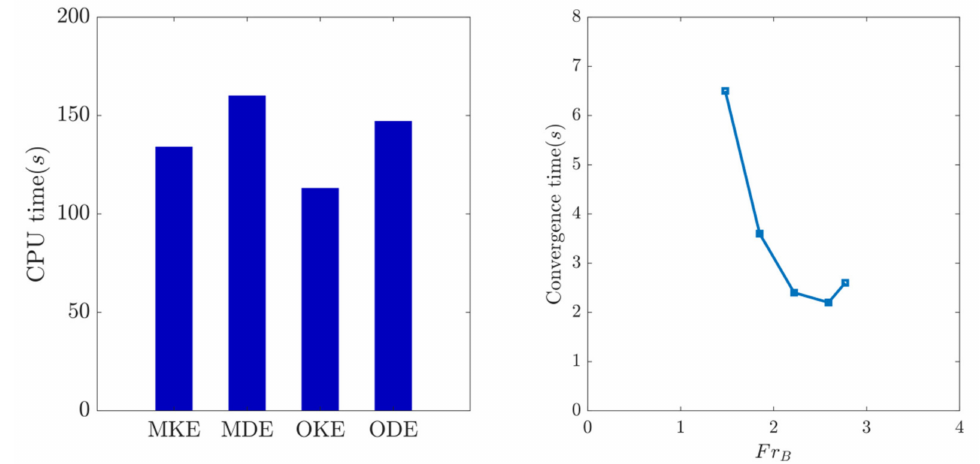
Figure 18. The amount of time required to numerically solve a time step ( left ) and the convergence time corresponding to different beam Froude Numbers ( right